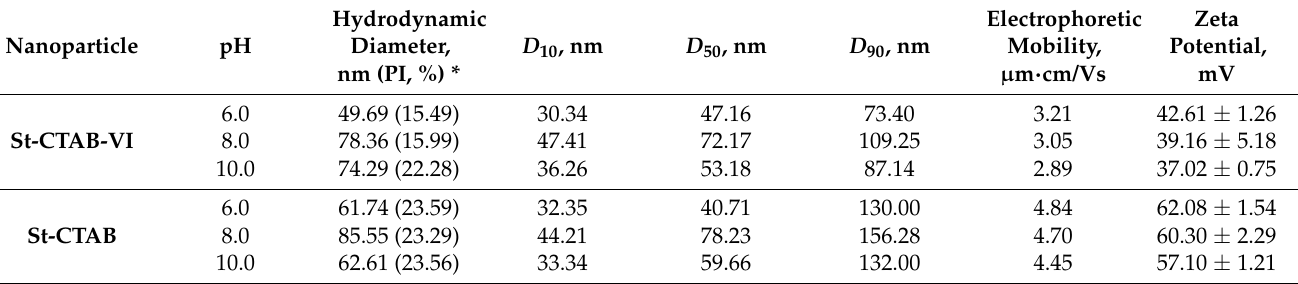
Table 2. Hydrodynamic diameter, particle distribution, electrophoretic mobility and zeta potential of NPs.